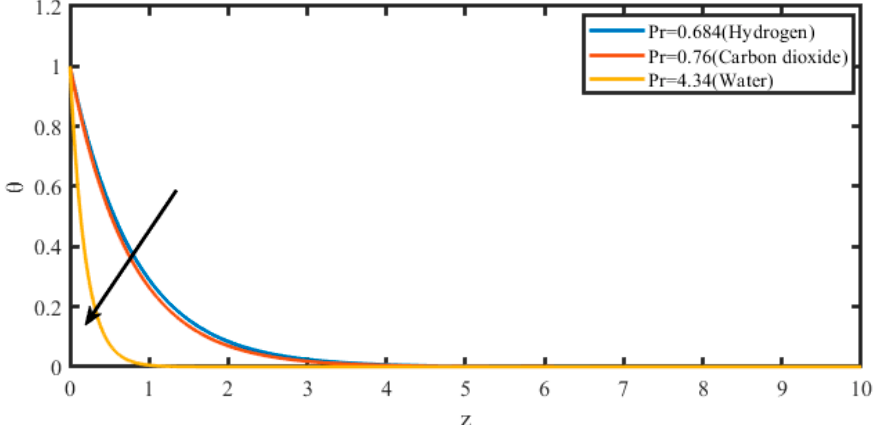
Figure 10. The influence of the radiation parameter F on the temperature profiles.